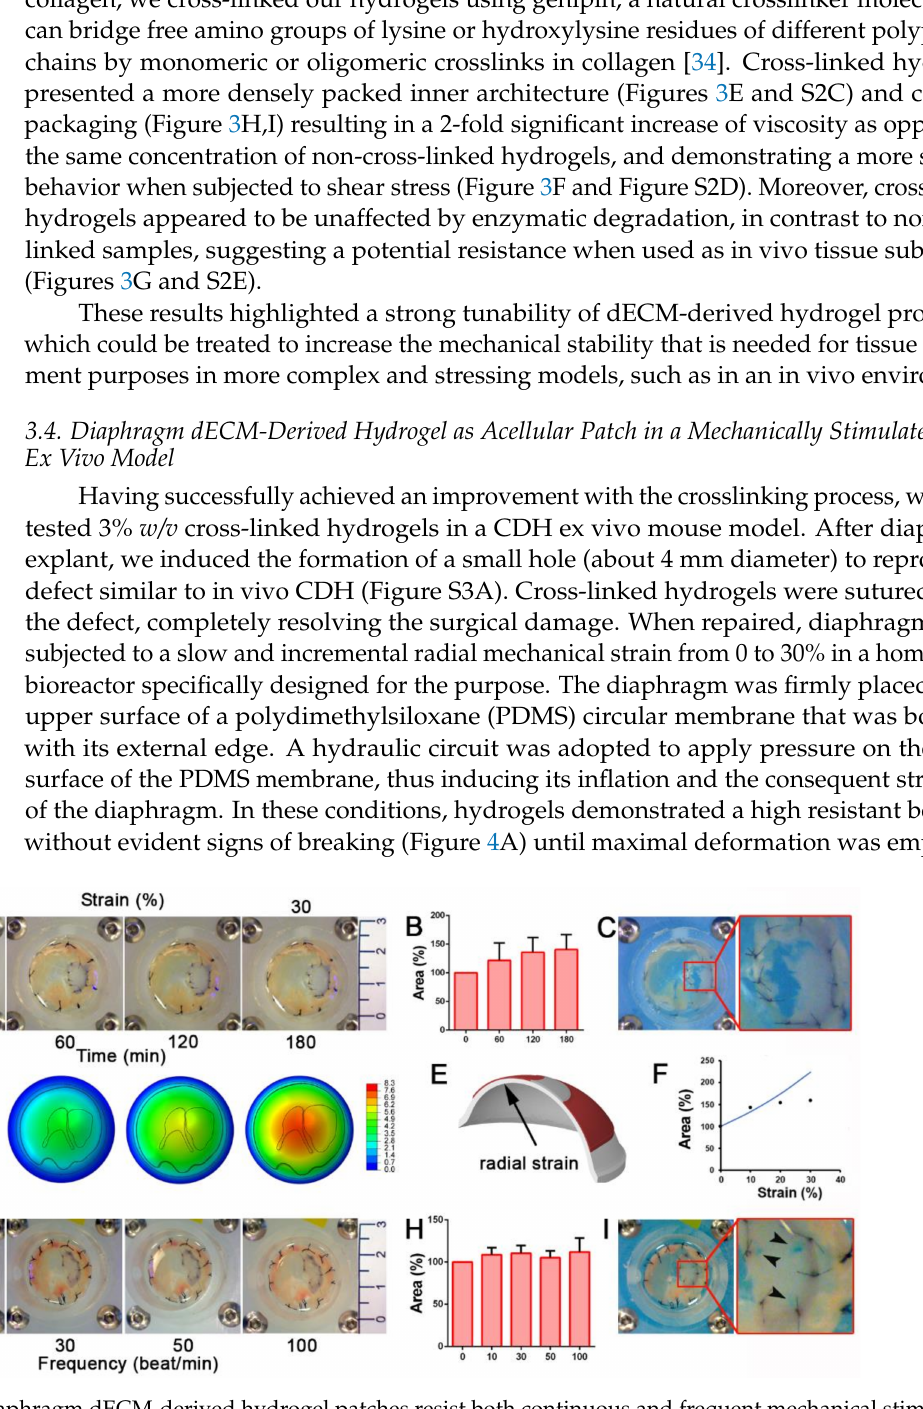
Figure 4. Cross-linked diaphragm dECM-derived hydrogel patches resist both continuous and frequent mechanical